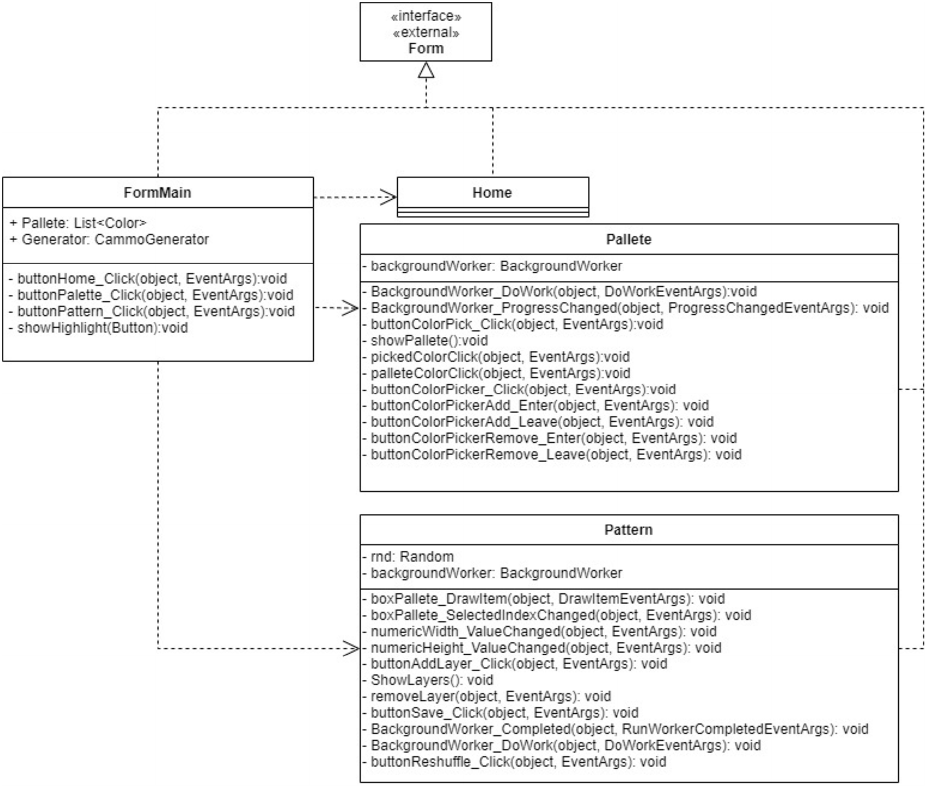
Figure 16. Graphic layer class diagram of CammoGenerator application.